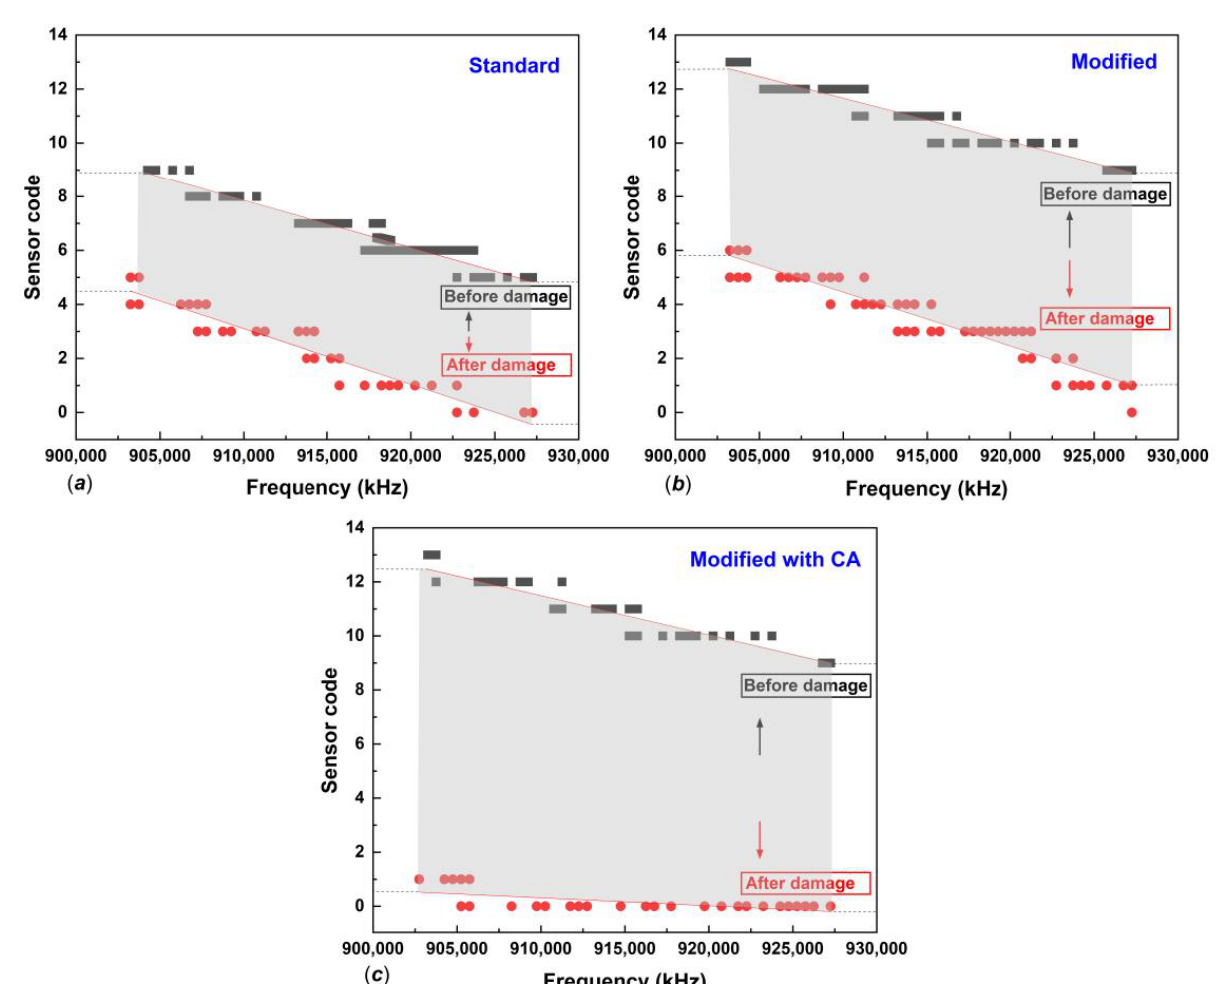
Figure 11. The sensitivity sensing performance of ( a ) standard smart tag, ( b ) MPGE tag, and ( c ) MPGE tag with a crosslinking agent.